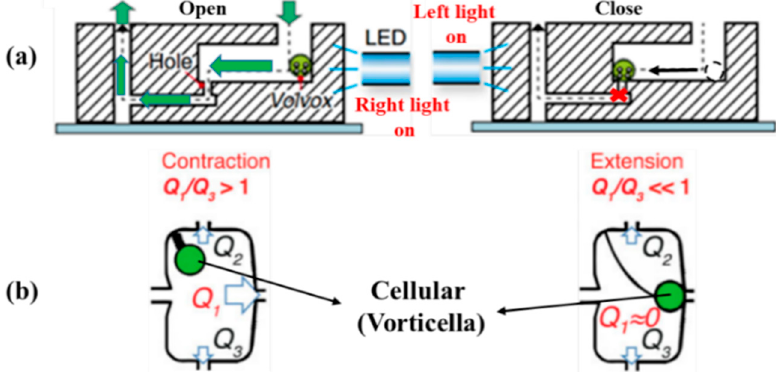
Figure 19. Schematic of two microvalves based on microorganism [113,114]: ( a ) V. carteri [113]; ( b ) Vorticella [114].